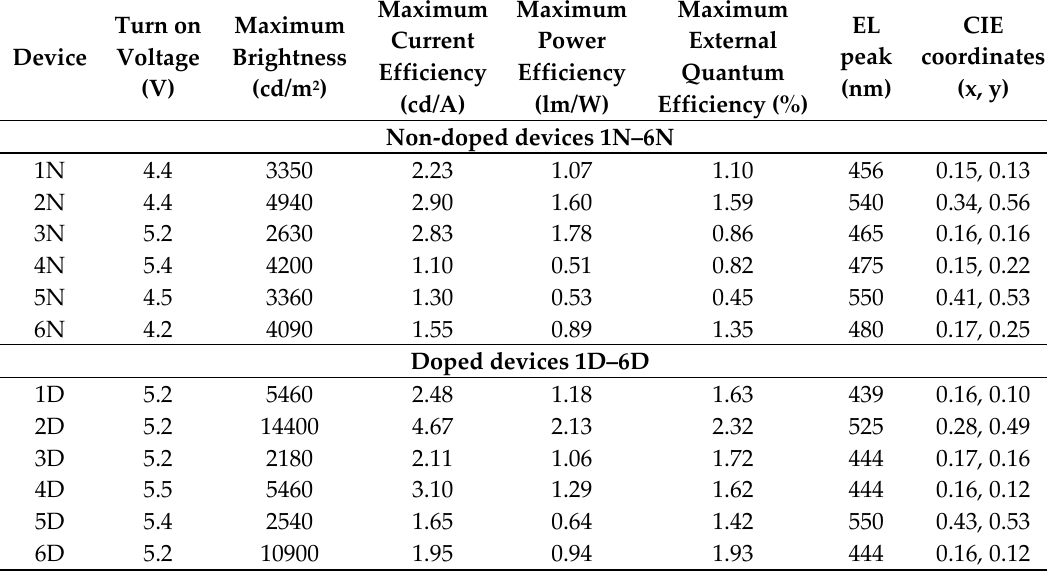
6 : mCP (Figure S4). The shapes of EL spectra of the doped devices were the practically same under different external voltages (Figure S7). CIE coordinates of the doped devices 1D – 6D were slightly shifted to deeper blue region in comparison to those of non ‐ doped devices 1N – 6N (Table 4). Table 4. The electroluminescent parameters of non ‐ doped 1N – 6N and doped 1D – 6D